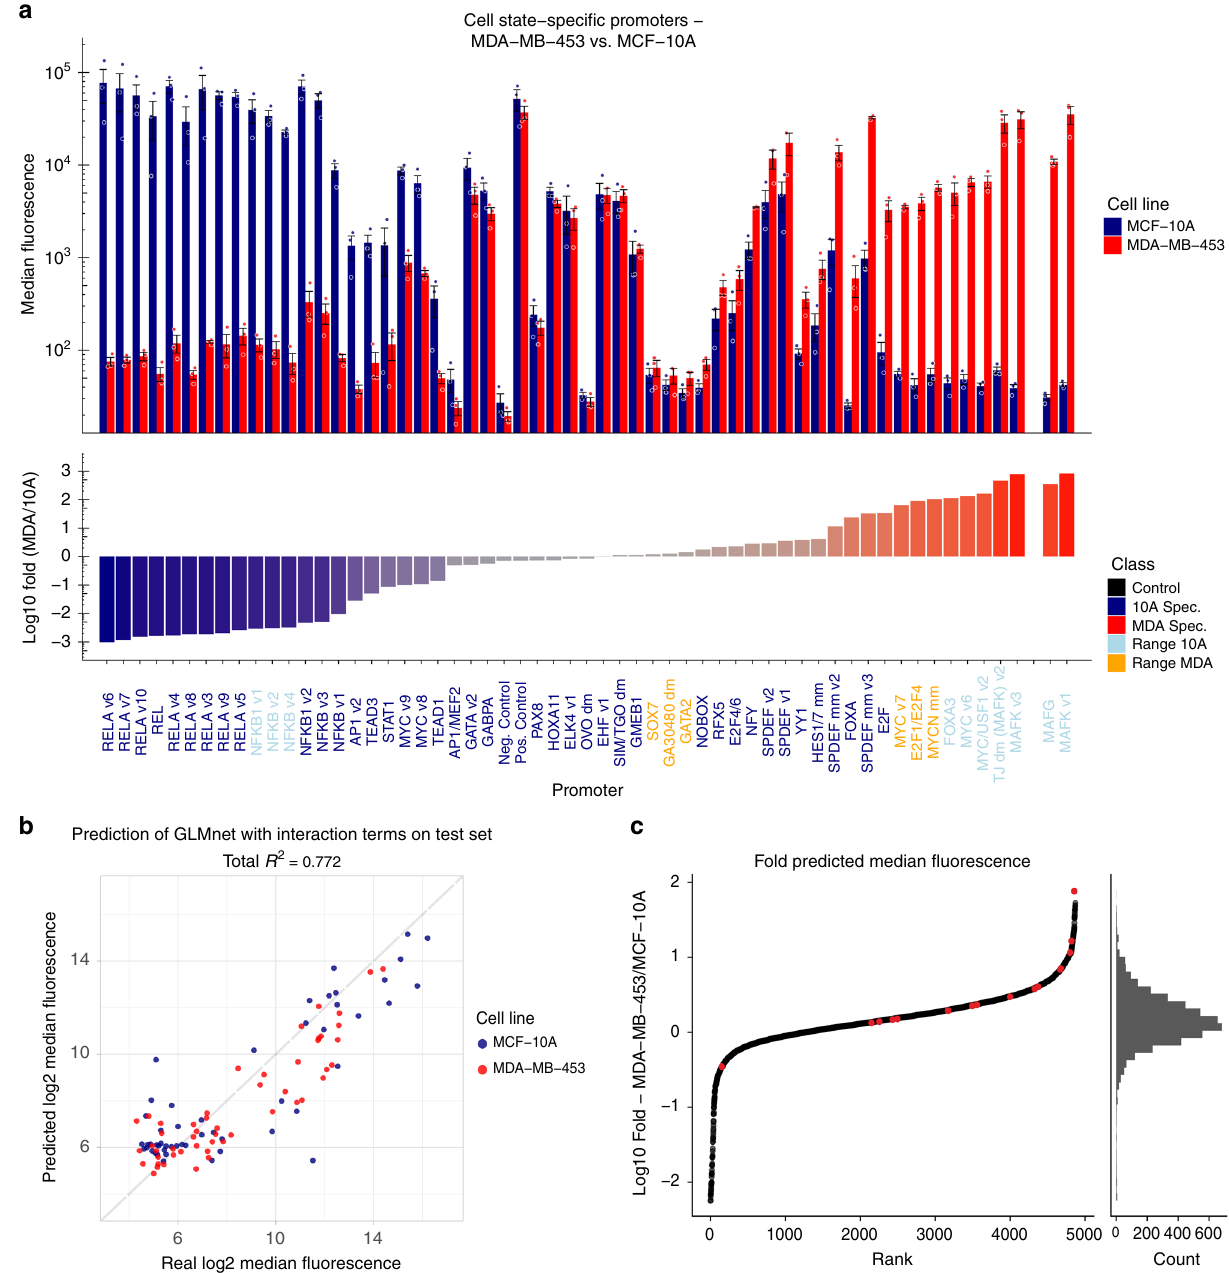
Fig. 3 Machine-learning based prediction model can ef fi ciently predict cell state speci fi city. a Validation guided by machine-trained algorithms. We selected 54 promoters predicted to be speci fi c to either of the cell states or to have a range of fl uorescence in either cell state (de fi ned as four “ classes ” of promoters). Speci fi c promoters showed up to ~1000-fold difference in activity between cell states and exhibited activity as strong as that of a constitutive promoter (Ubiquitin C promoter) commonly used for gene expression (also used as the positive control, Pos. Control). The negative control sample (Neg. Control) consisted of cells infected with a non- fl uorescent protein. Names refer to the TF-BS in the promoter. All the promoters shown here are taken from the newly generated validation set, except for MAFK v1, which was identi fi ed by the Top 5% approach, and MAFG, which was taken from the training data. The dots represent the values of three biological replicates. b The machine-learning based prediction model achieved a Pearson R 2 of 0.77 between the prediction and true fl uorescence measured by FACS (log2 scaled) on a held-out test set. c Inspecting the predicted fold difference of all promoters in the library showed that there were plenty of promoters speci fi c to each cell state. The Top 5% approach identi fi ed cell state-speci fi c promoters (in red) in a signi fi cant manner ( p = 0.0016, Wilcoxon rank sum test, two-sided). Error bars represent S.E.M., N = 3 biological replicates. Source data are provided as